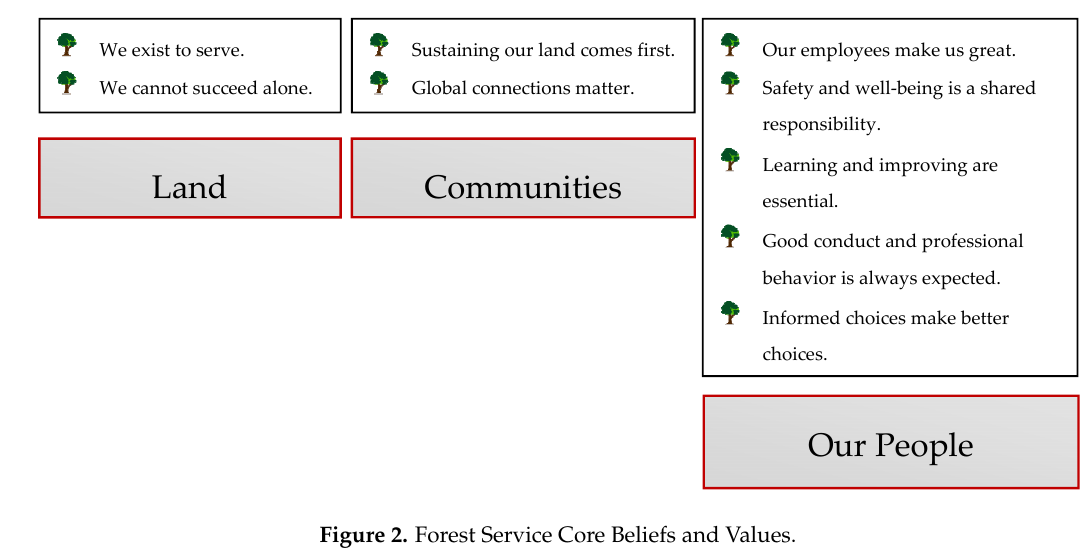
Figure 2. Forest Service Core Beliefs and Values.